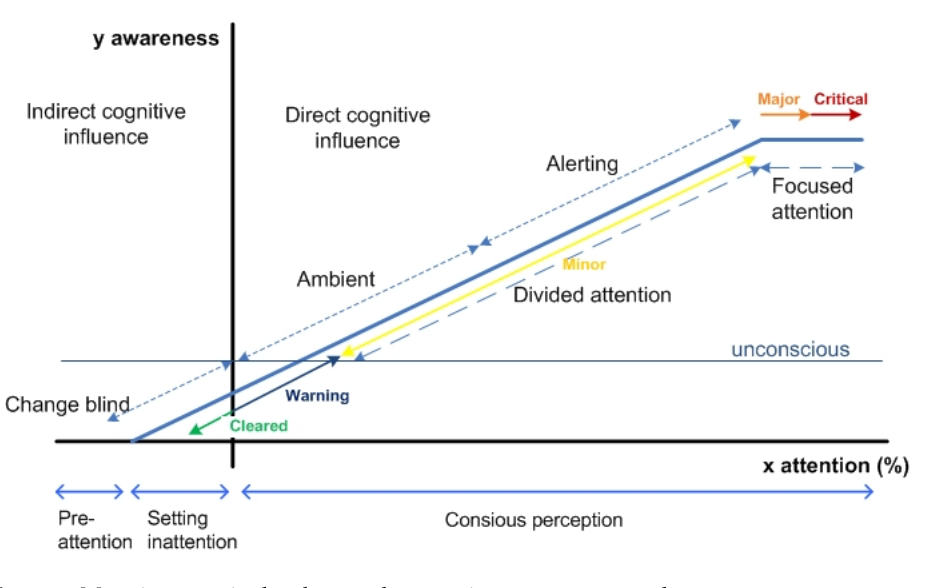
Figure 5. Mapping severity levels onto the attention-awareness graph.